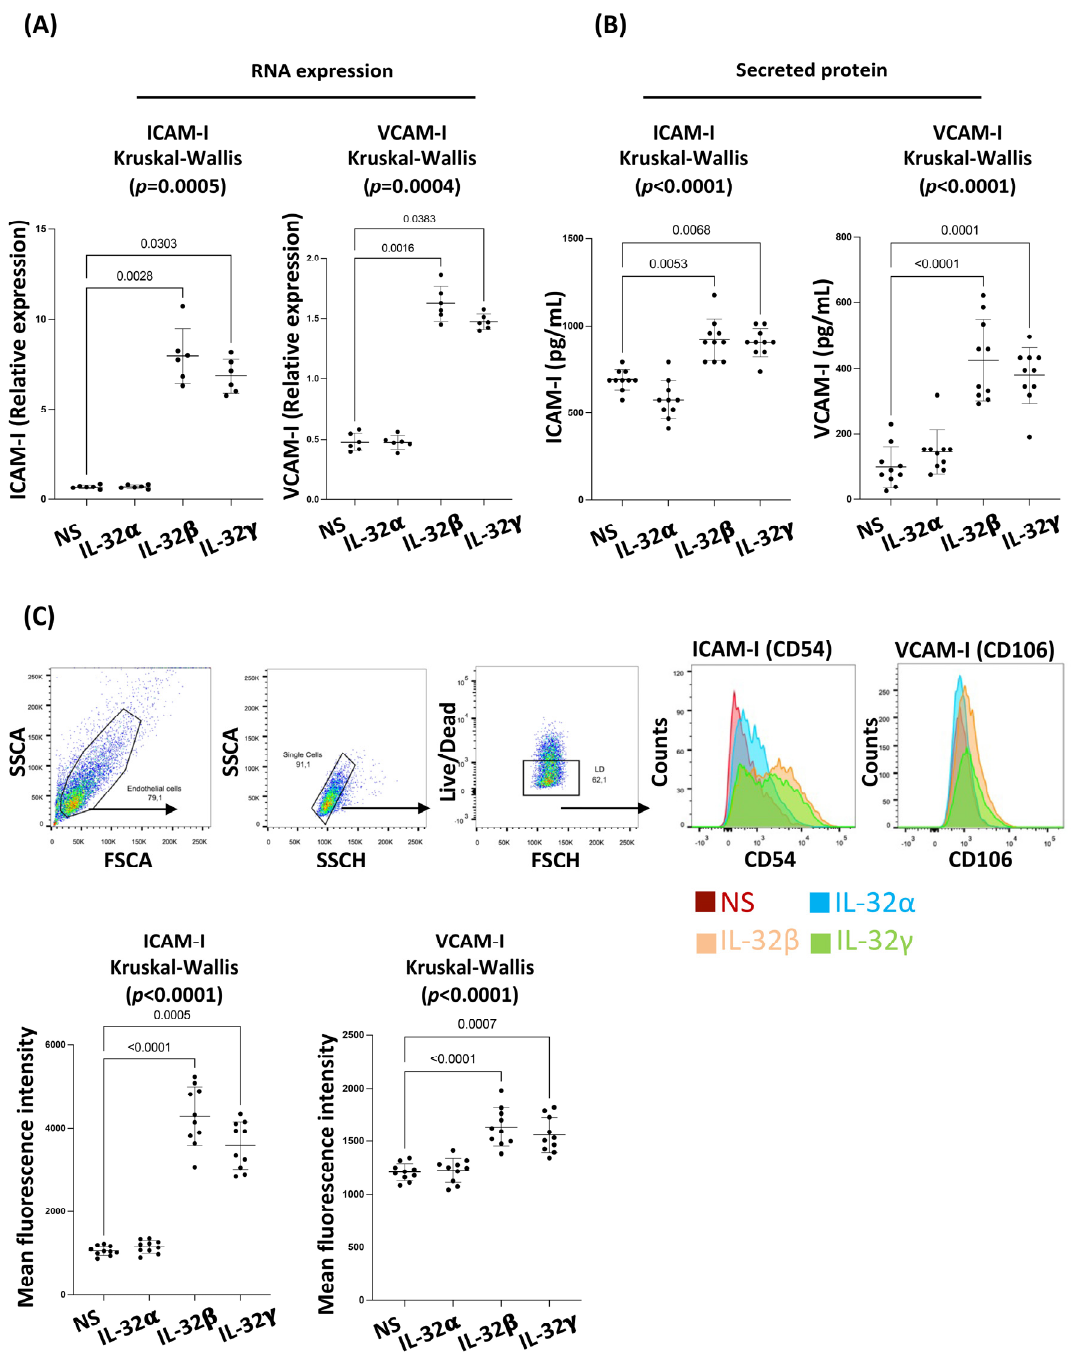
Figure 2. Coronary artery endothelial cell dysfunction markers are upregulated by IL-32 isoforms β and γ but not α . ( A ) Analysis of ICAM-I (CD54) and VCAM-I (CD106) RNA expression, normalized to the housekeeping gene β -glucuronidase, in primary CAEC showing their increased relative expression following 12 h stimulation with IL-32 β and γ but not α (500 ng/mL, n = 6). ( B ) Analysis of ICAM-I and VCAM-I expression in CAEC supernatants following stimulation with IL-32 α , β and γ for 72 h (n = 10). ( C ) Upper panels: Representative Flow cytometry data showing the gating strategy on CAEC live cells and overlapping histograms for ICAM-I and VCAM-I on the cell surface following stimulation with IL-32 α , β and γ for 72 h (500 ng/mL). Lower panels: Analysis of ICAM-I and VCAM-I surface expression from n = 10 treatments (10 experimental replicates from CAEC). Data analyzed with the nonparametric test Kruskal-Wallis and Dunn’s subtest. NS: